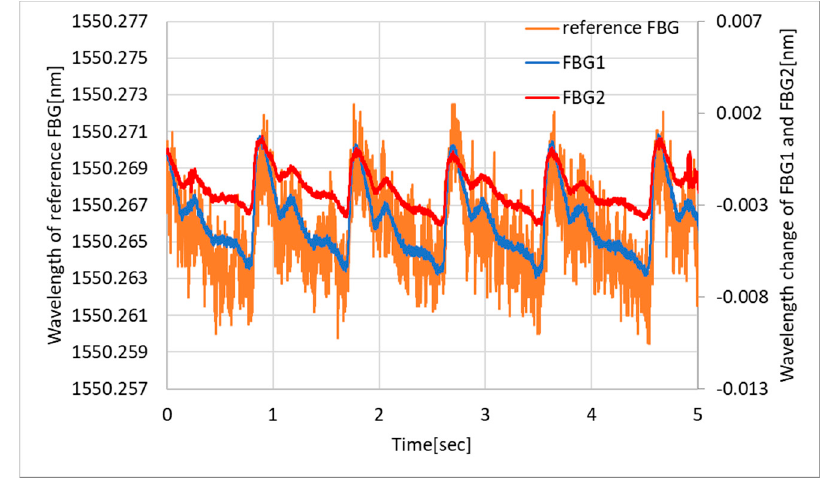
Figure 9. Plethysmogram obtained with the developed FBG interrogator and commercially available interrogator.